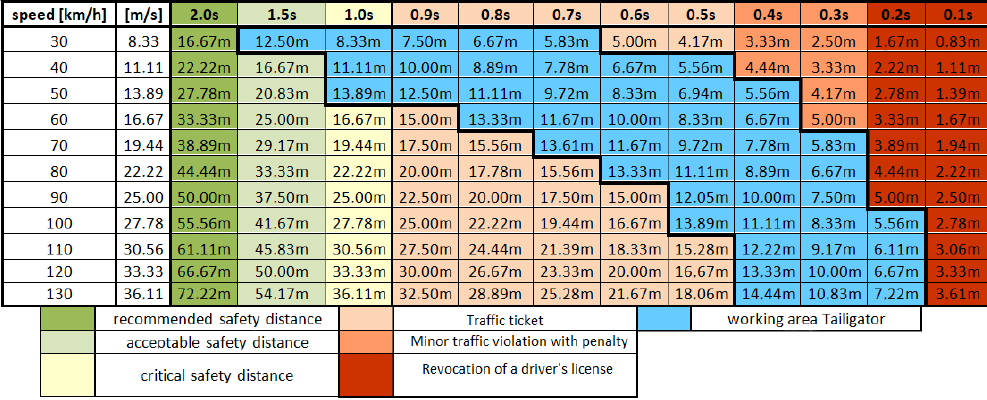
Figure 8. Working area of the Tailigator on curved road sections (blue marked area). Table 4. Distance (meters) related to time (seconds) and speed (kilometers per